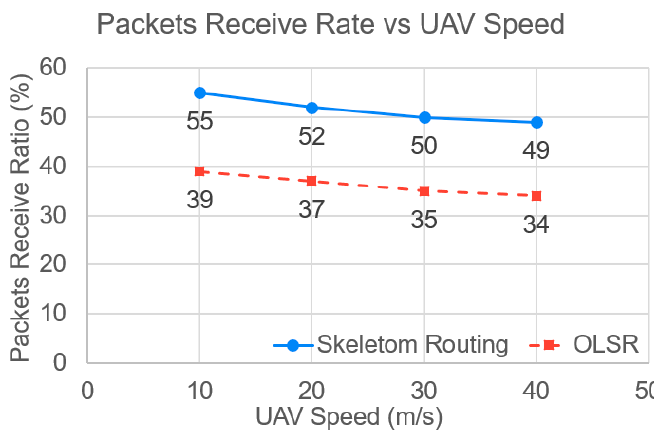
Figure 22. Throughput results with varying node speeds.